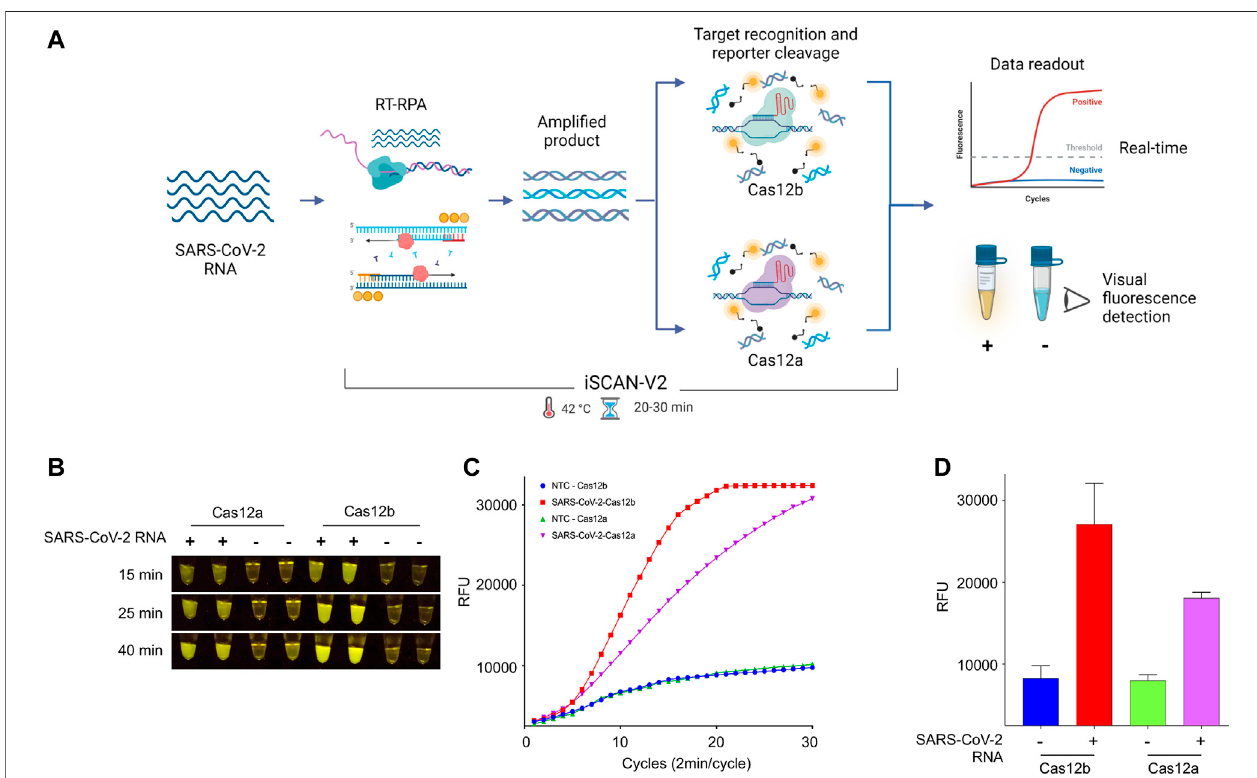
FIGURE 2 | The iSCAN-V2 assay with Cas12b can ef fi ciently detect SARS-CoV-2. (A) Schematic of CRISPR/Cas12a- and Cas12b-based detection of SARS- CoV-2. Total RNAwassubjected totheiSCAN-V2one-pot assay.The collateral cleavage ofthe ssDNA-labelled HEXreporterprovided in thesame reaction produces a fl uorescent signal for visual detection. (B) iSCAN-V2-based detection of SARS-CoV-2. Synthetic SARS-CoV-2 RNA was subjected to the one-pot iSCAN-V2 platform using Cas12a or Cas12b. (+) indicates SARS-CoV-2 and ( − ) indicates the no-template control (nuclease-free water). For end-point fl uorescence visualization of SARS-CoV-2 N -genetargetsequencedetection,sampleswereimagedinaP51molecular fl uorescenceviewer. (C) Real-timedetectionofsyntheticSARS-CoV-2RNA. The iSCAN-V2 assay was performed to determine the real-time ef fi ciency of Cas12a- and Cas12b-based target detection. Nuclease-free water was used as the no- template control (NTC). The intensity of the fl uorescent signal was measured every 2 min for a period of 1 h using the HEX channel in a CFX96 Real-Time PCR System (Bio-Rad). Values are shown in the graph as means of 3 independent readings. (D) Graphical representation of iSCAN-V2 end-point detection performed with CRISPR/ Cas12a and Cas12b. The iSCAN-V2 assay was performed as in (B,C) . ( − ) indicates the no-template control (nuclease-free water). The HEX channel was used to measure the fl uorescent signal intensity with a CFX96 Real-Time PCR System (Bio-Rad). Values are shown in the graph as means ± SD ( n (cid:1) 3).